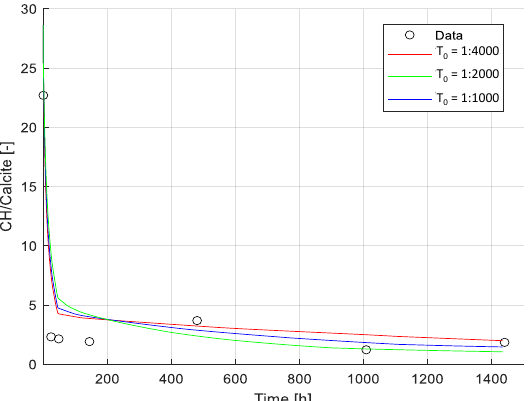
Figure 10. Calibration of tortuosity factor. Comparison between model results (for different tortuosity factors) and experimental data (i.e., Portlandite-to-Calcite ratio). Results presented correspond to the ratio of Portlandite/Calcite during the exposure time (shown in linear scale). Experimental data was derived from TGA measurements. Modeled results are shown for three values of the initial tortuosity factor (T 0 ): T 0 = 1:1000, T 0 = 1:2000, T 0 = 1:4000.